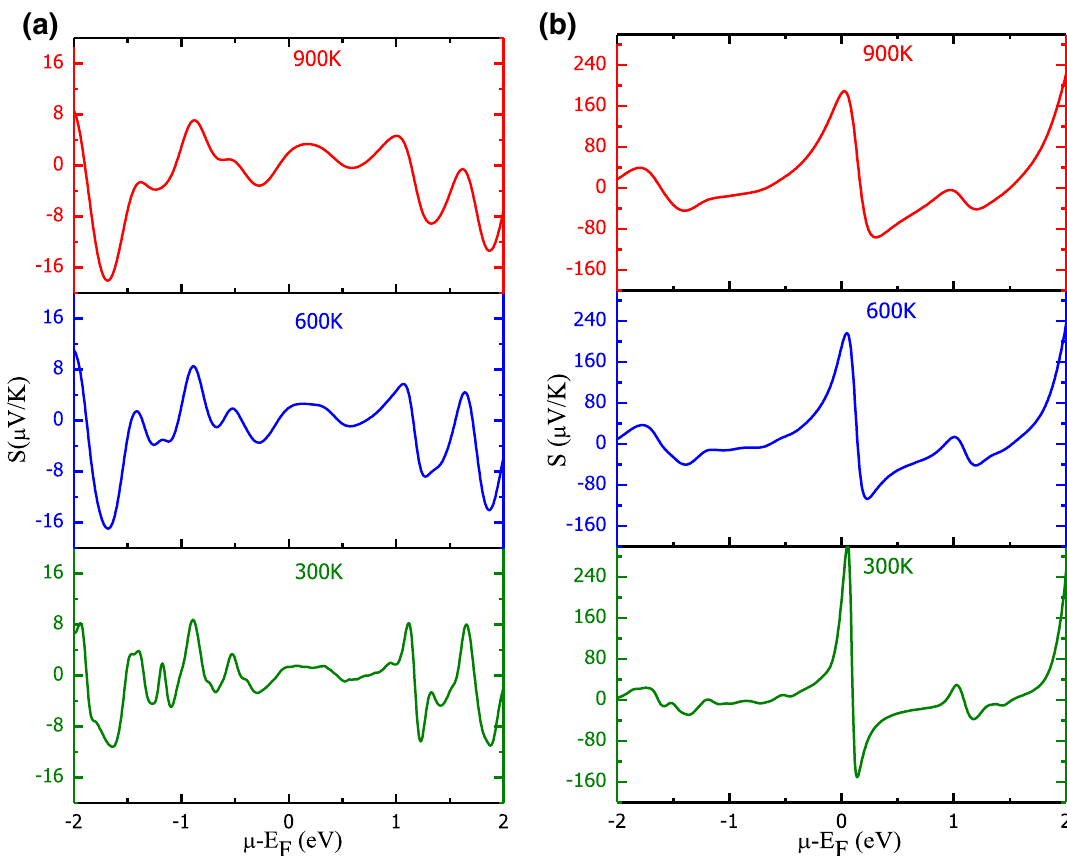
Figure 7. Total Seebeck coefficient as a function of chemical potential and temperature: ( a ) Ba 2 FeNiO 6 ; ( b ) Ba 2 CoNiO 6